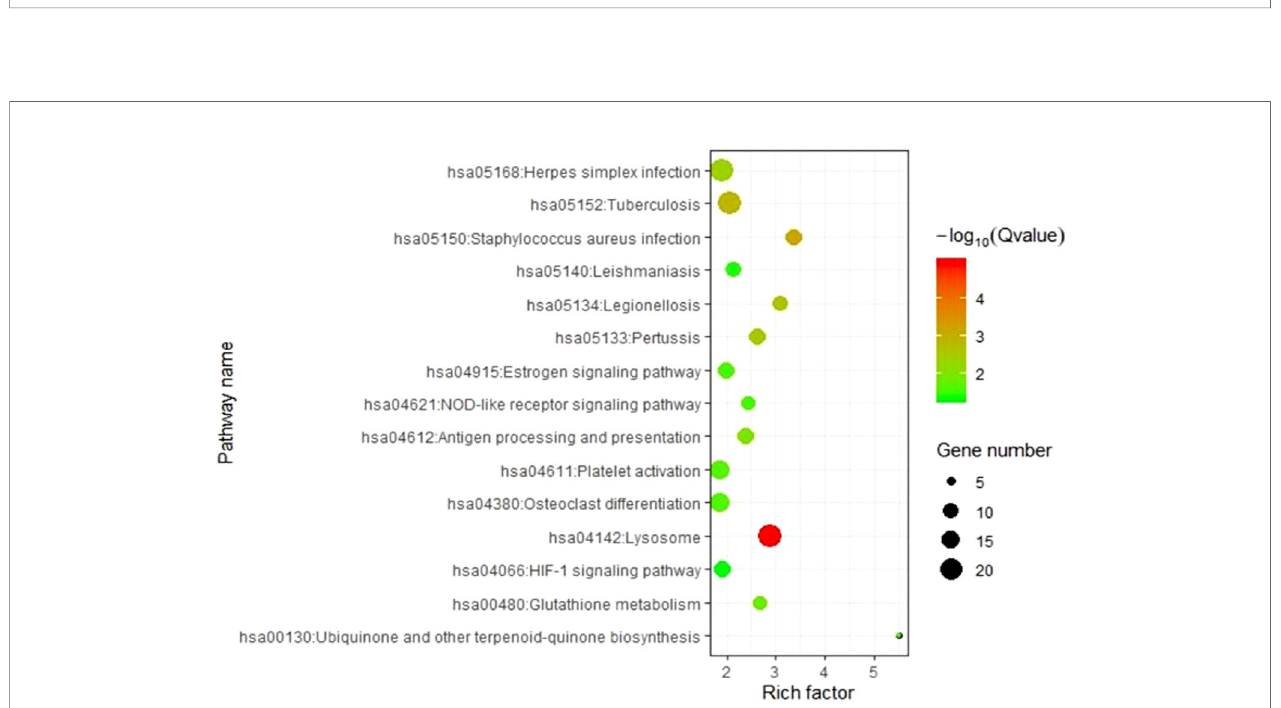
FIGURE 3 | KEGG analysis revealed genes respond to m 6 A-cis-eQTLs are enriched diverse pathways. Note that Staphylococcus aureus infection pathway is with high signi fi